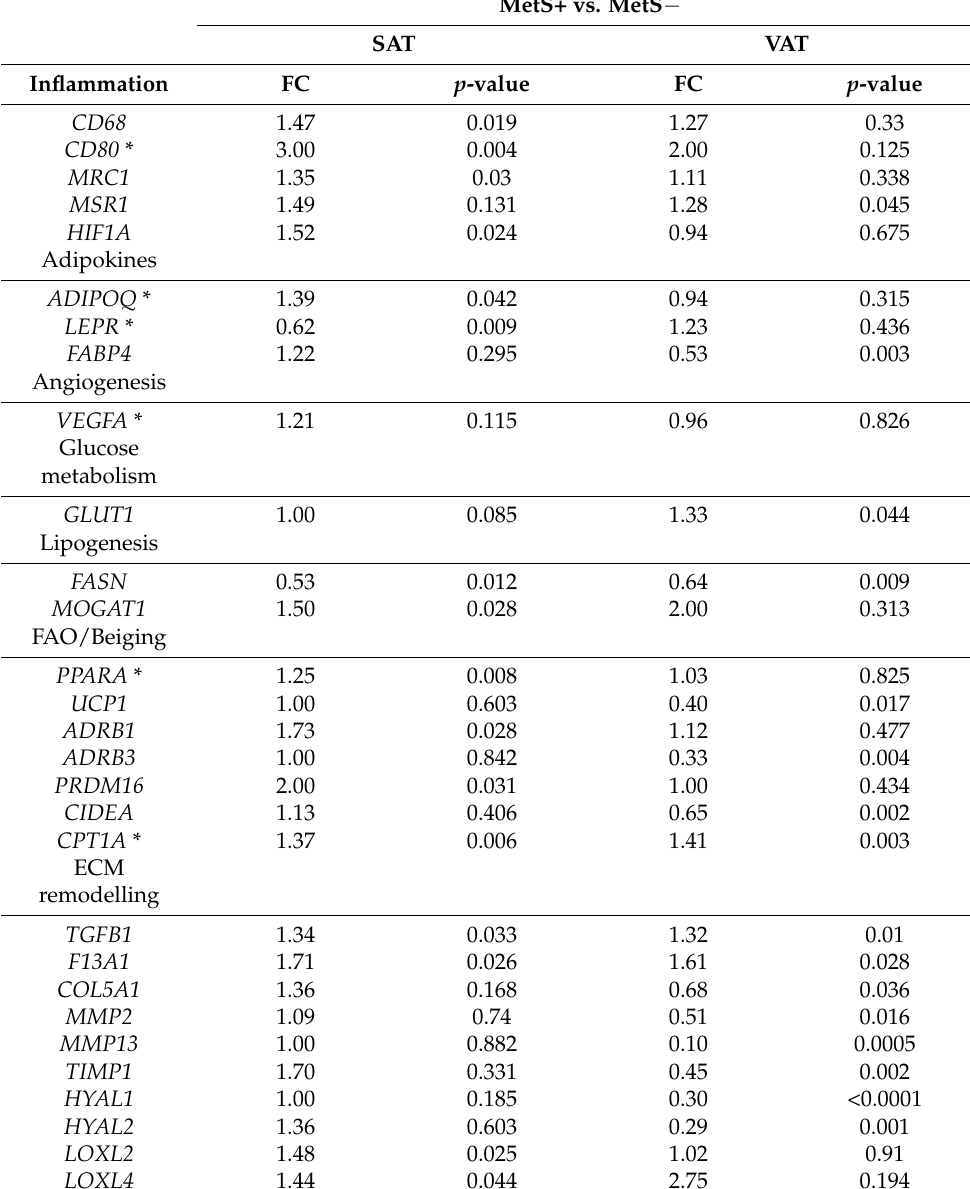
Table 3. Differential gene expression